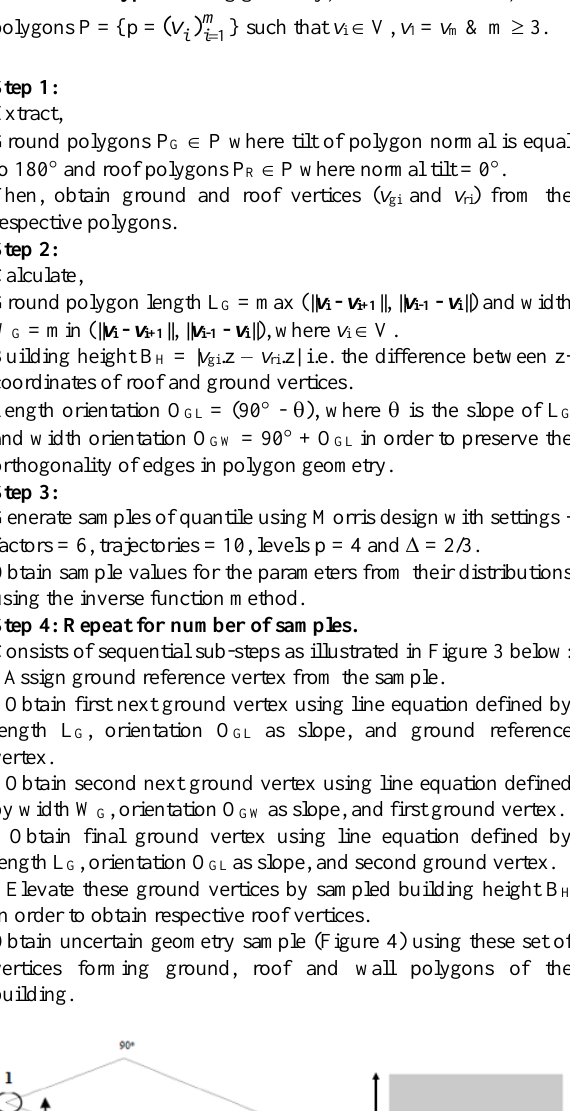
Figure 4. Uncertain geometry instance deviating from highlighted reconstructed geometry